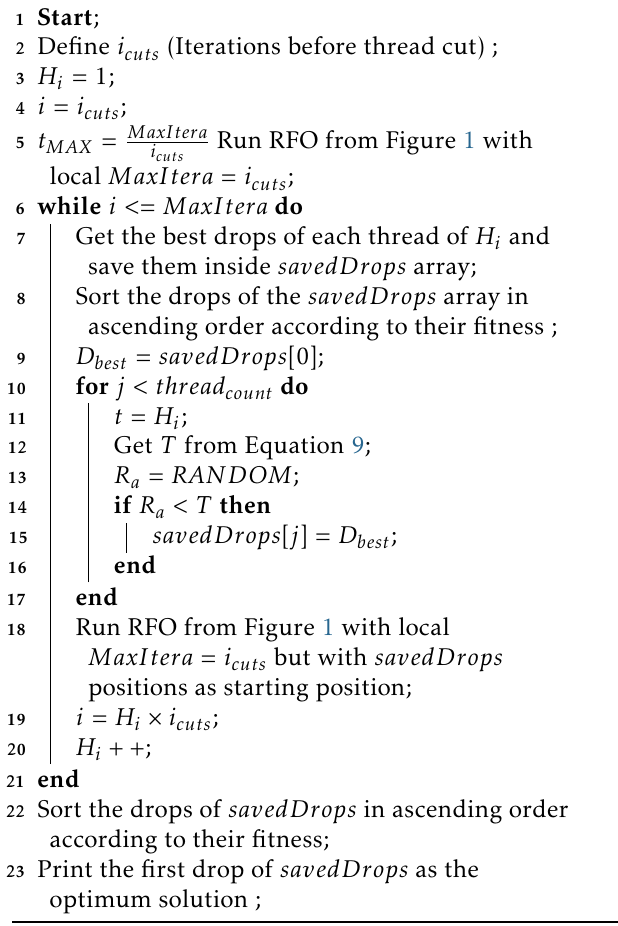
Algorithm 3: Pseudocode to obtain the best drop of H